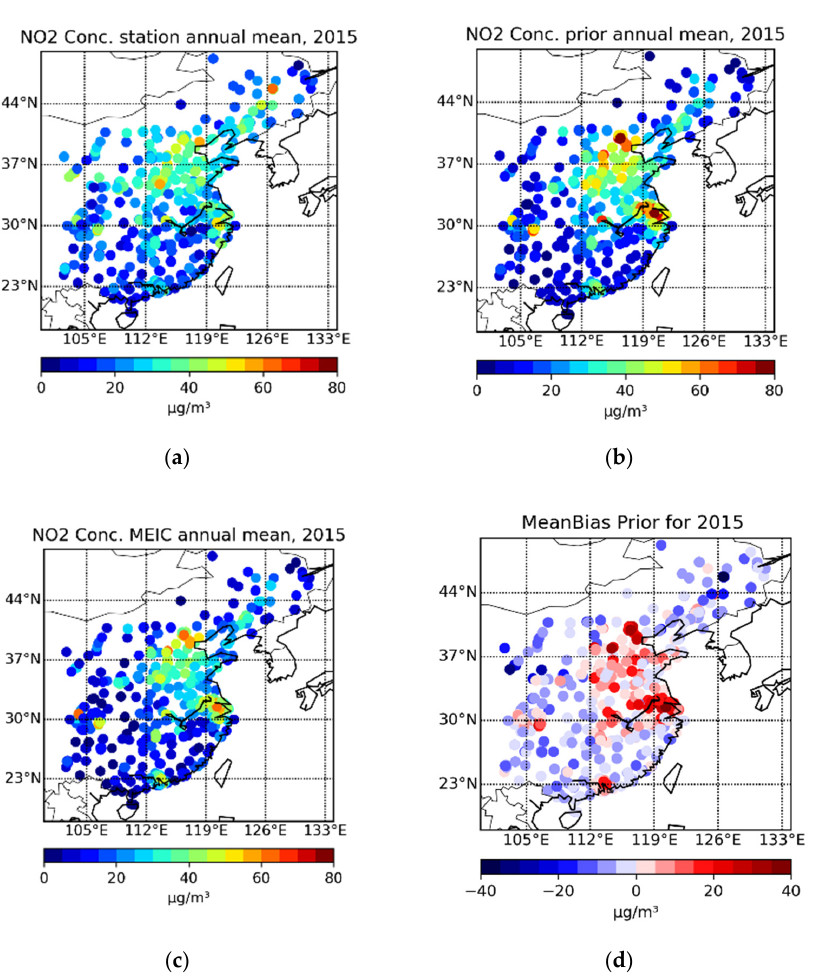
Figure 3. Spatial distribution of annual mean surface NO 2 concentrations: ( a ) Stations; ( b ) CHIMERE using prior emissions (Conc_Prior15); ( c ) CHIMERE using MEIC emissions (Conc_MEIC15), and ( d ) Mean bias calculated by the mean differences between Conc_Prior15 and stations for 2015.